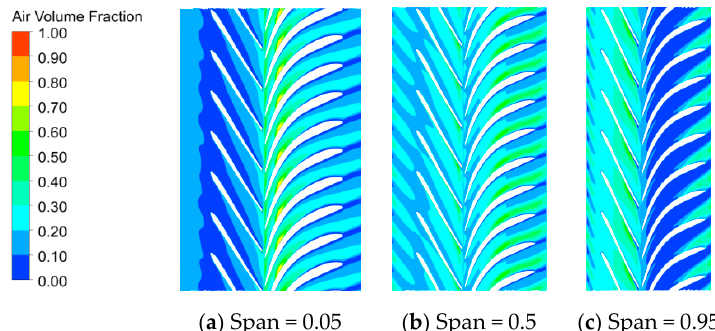
Figure 9. GVF distribution at diverse spans in the second stage impeller and diffuser under IGVF = 20%.